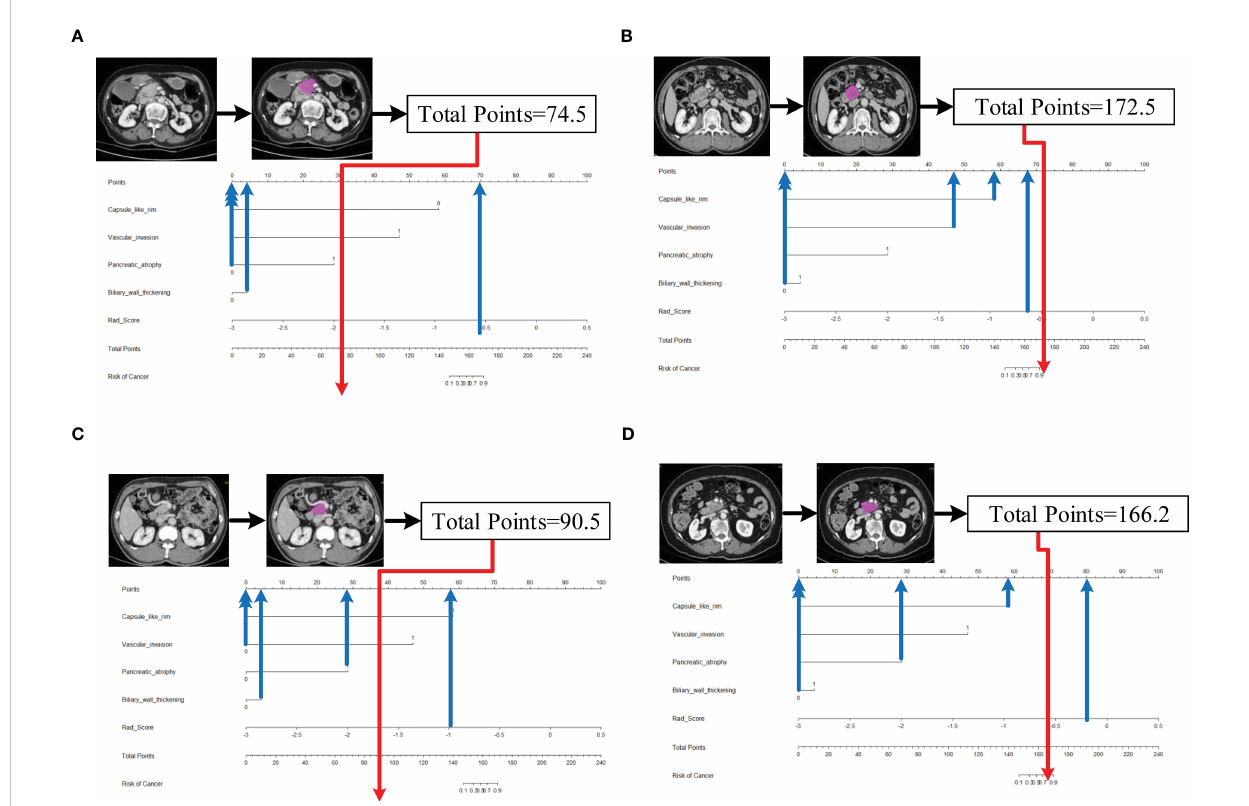
FIGURE 7 Schematic diagram of prediction fl ow of radiomics nomogram model. (A) after VOI delineating, image preprocessing, the value of total points was 74.5, which was calculated by the CT fi ndings and Rad-Score. The result corresponded to <10% probability of a fi rm consistency. Thus, the patient ’ s disease was predicted to be fAIP, which was con fi rmed by ICDC. (B) The total points was 172.5, which corresponding to >90% probability of a fi rm consistency. Thus, the patient ’ s disease was predicted to be PDAC, which was con fi rmed in surgery. (C) The external validation data, the total points was 90.5. Thus, the patient ’ s disease was predicted to be fAIP, which was con fi rmed by ICDC. (D) The external validation data, the total points was 166.2. Thus, the patient ’ s disease was predicted to be PDAC, which was con fi rmed in surgery.